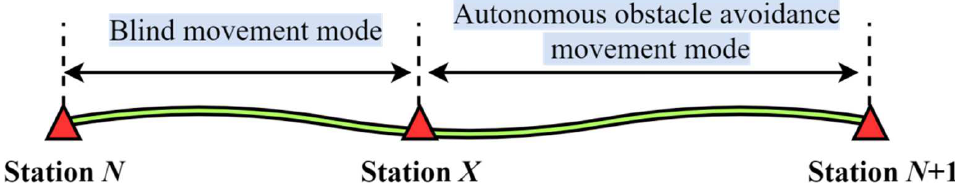
Figure 11. The Schematic diagram of Zhurong